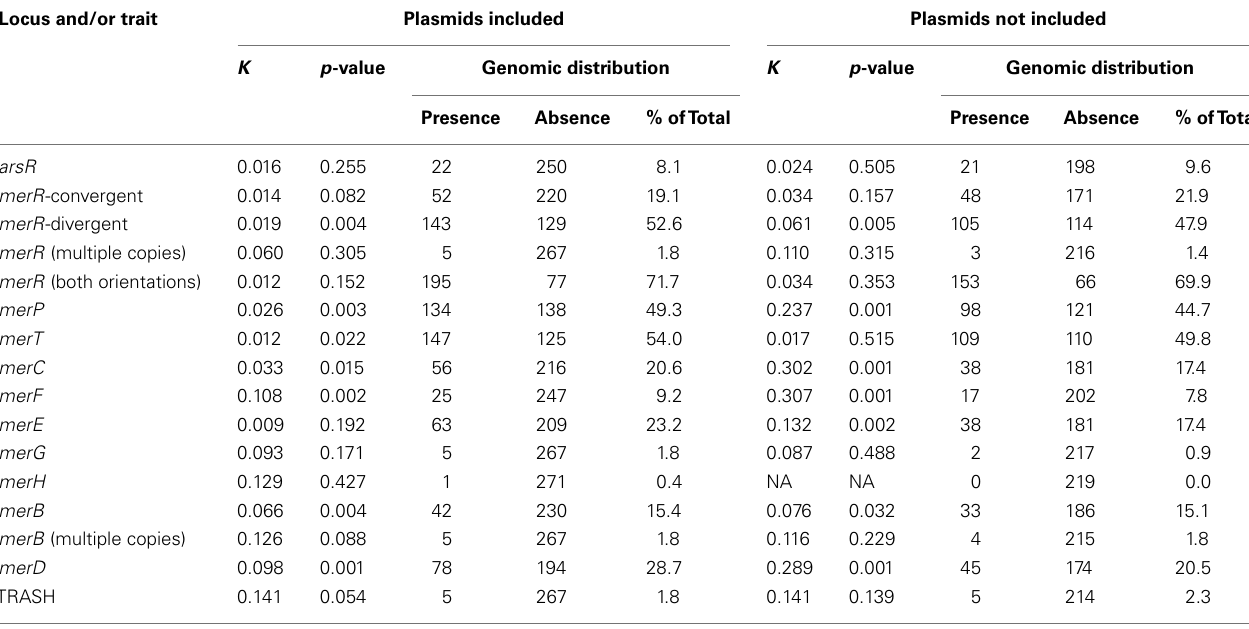
Table 1 | Phylogenetic signal ( K value) and associated p -value of mer operon functions when mapped on a MerA phylologenetic tree. Locus and/or